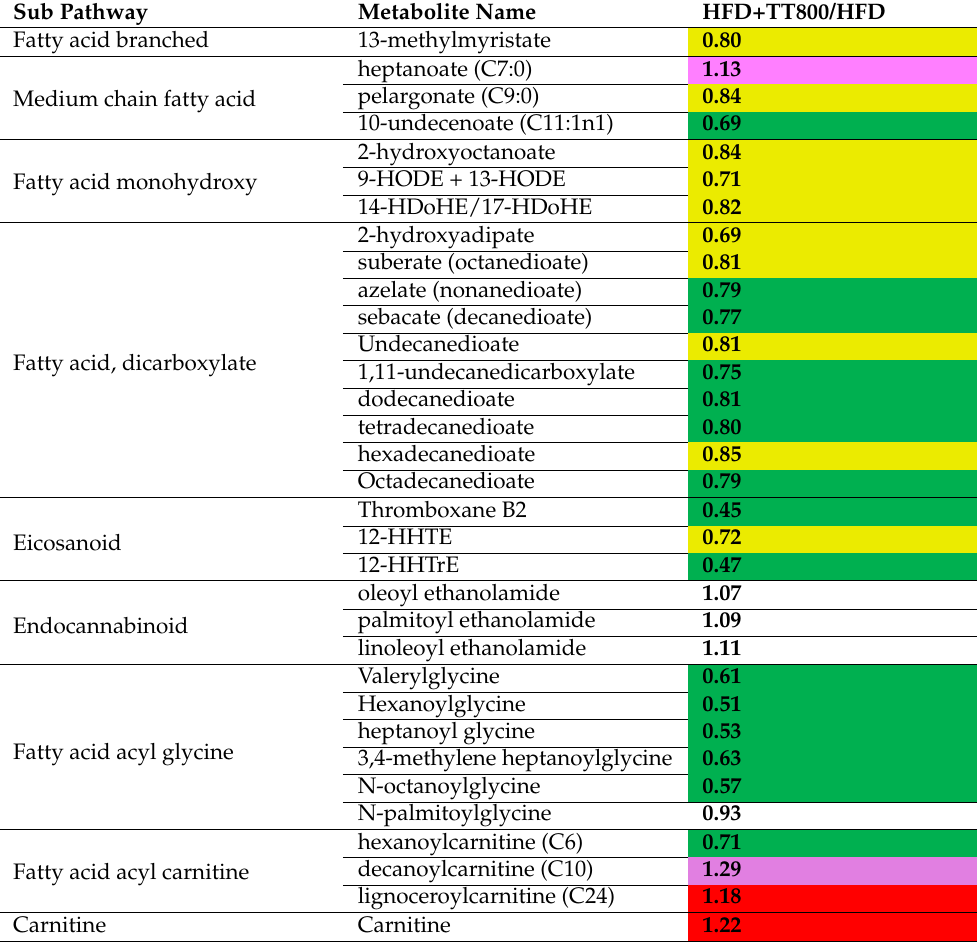
Table 2. Effects of TT supplementation on serum fatty acid metabolites in mice fed HFD compared to the HFD control